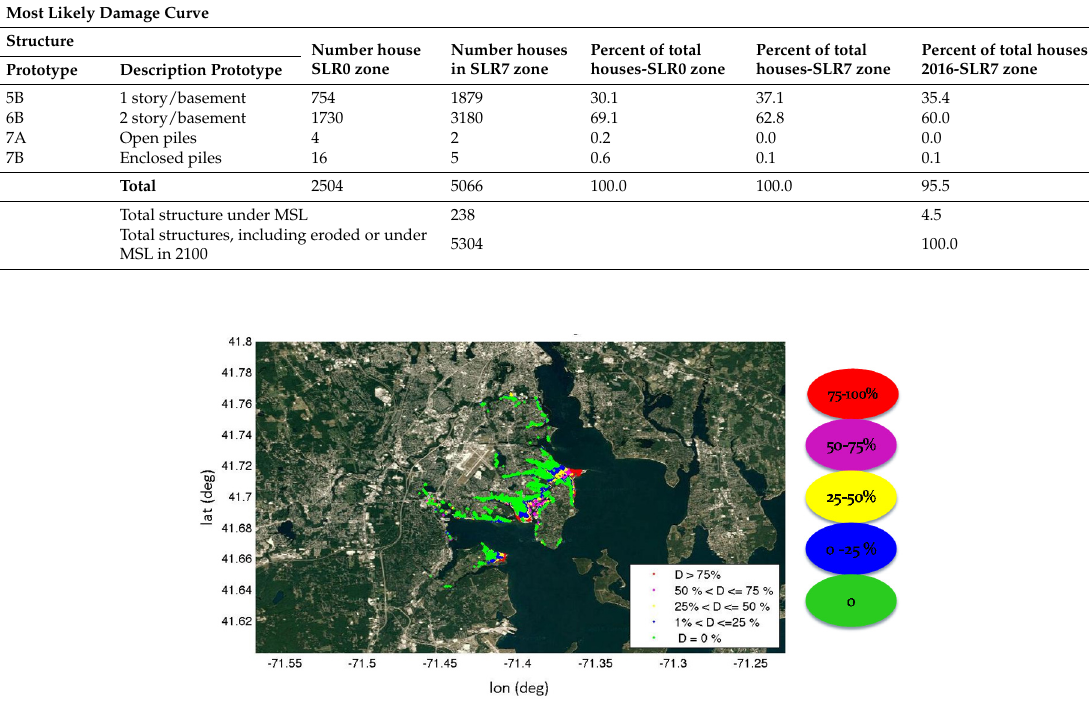
Figure 18. Cumulative structure and content damage curves for Warwick, RI, 100 year. Content damage (C) is shown by the dashed lines and structural damage(S) by the solid lines. Results are shown for the minimum, most likely, and maximum damage function curves. Simulations were repeated for the 100 year plus 2.1 m (7 ft) SLR scenario. The total water level map for this case is provided in Figure A6. Table 4 shows the number of structures by prototype class for this case. The number of structures increases to 5304, more than double the number for the no SLR case (2504). 5B account for 35.4% and 6B for 60% of the structures while 4.5% are below MSL. Structures on piles are mainly eliminated given their proximity to the coast and low FFEs. The percent damages by structure for the 100 year are shown in Figure 19 for this case. Black dots are structures that have been eliminated by erosion and white dots structures that are below MSL. Higher resolution maps are provided in Figure A7.